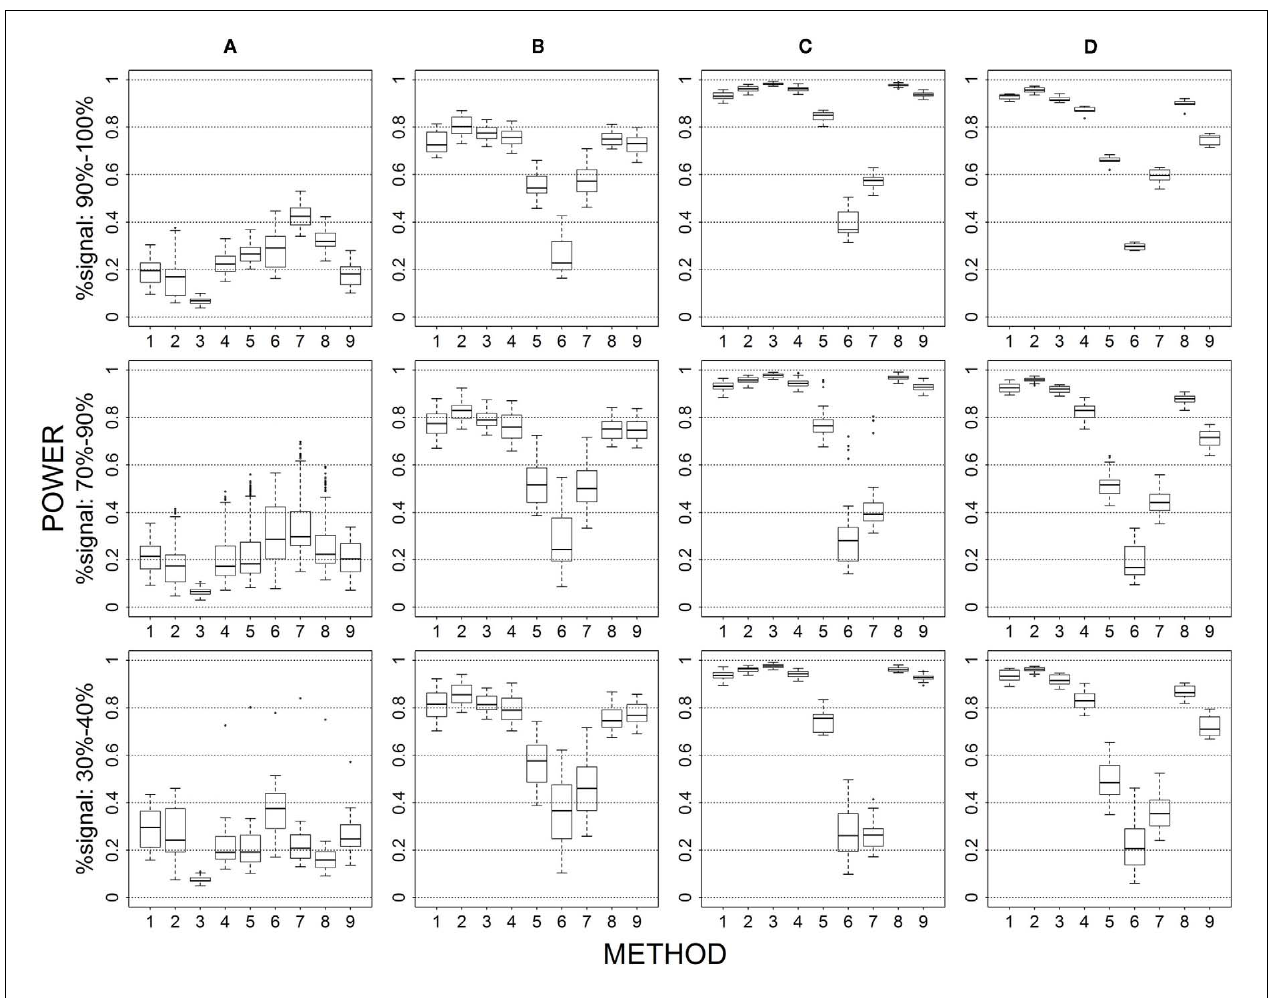
power results for marker-combinations belonging to each average functional allele frequency [ (A) is 0–0.02, (B) is 0.04–0.06, (C) is 0.08–0.11, (D) is 0.13–0.15] and percent-signal category; 1 = CMC01, 2 = CMC05, 3 = SimReg0, 4 = SimReg3, 5 = SimReg4, 6 = SKATsr, 7 = VT, 8 = 2Stage, 9 = MinP.